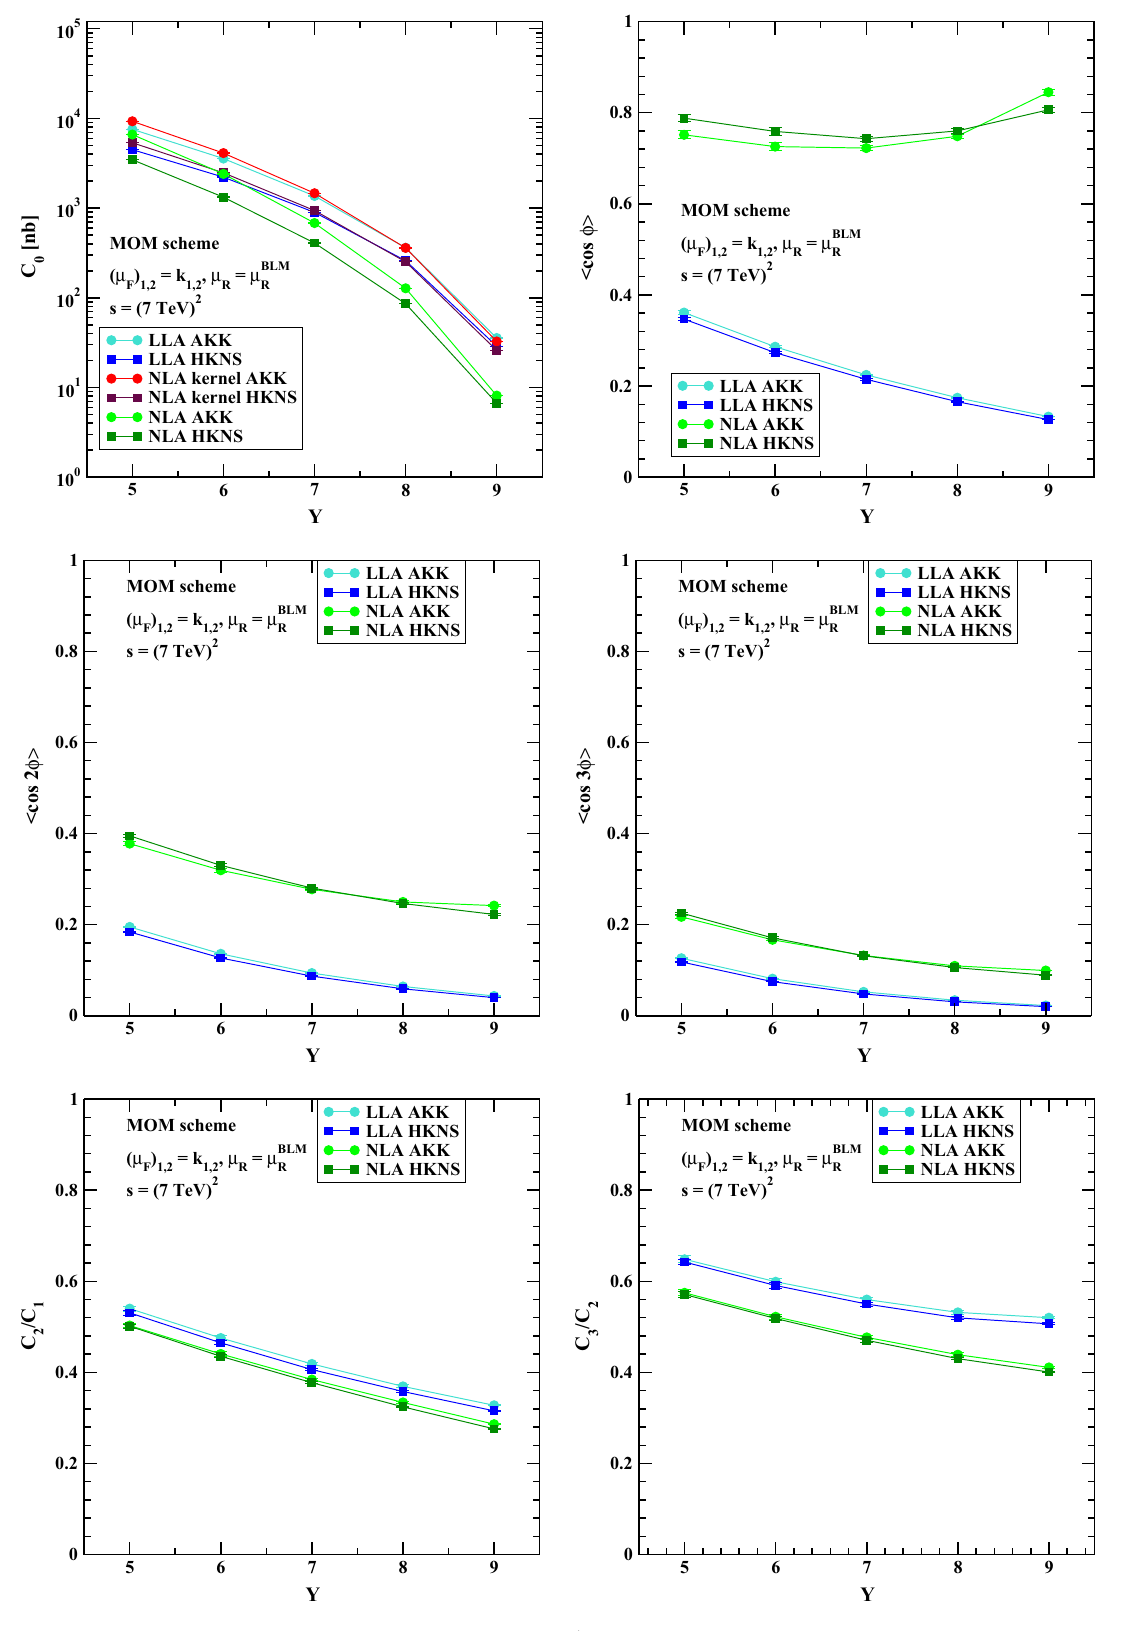
Fig. 11 Y -dependence of C 0 and of several ratios C m / C n for (μ F ) 1 , 2 = |(cid:6) k 1 , 2 | ,